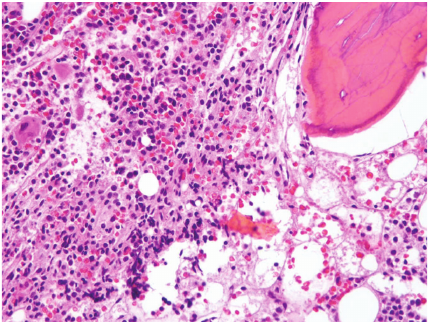
Figure 1: Hypercellular bone